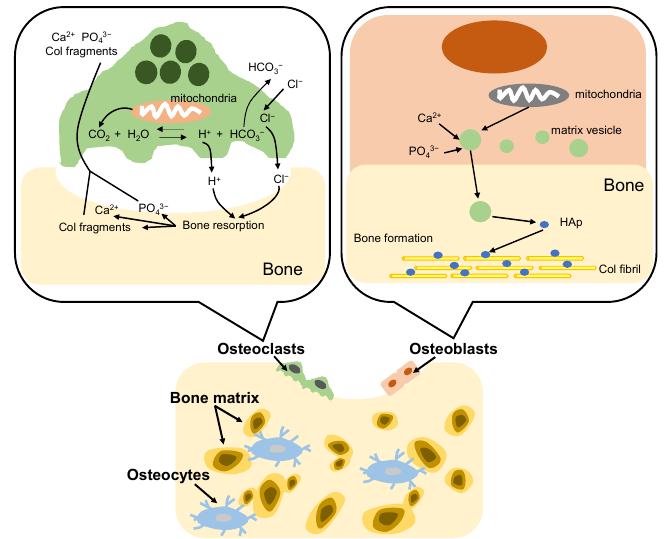
Figure 7. Illustration of bone remodeling.